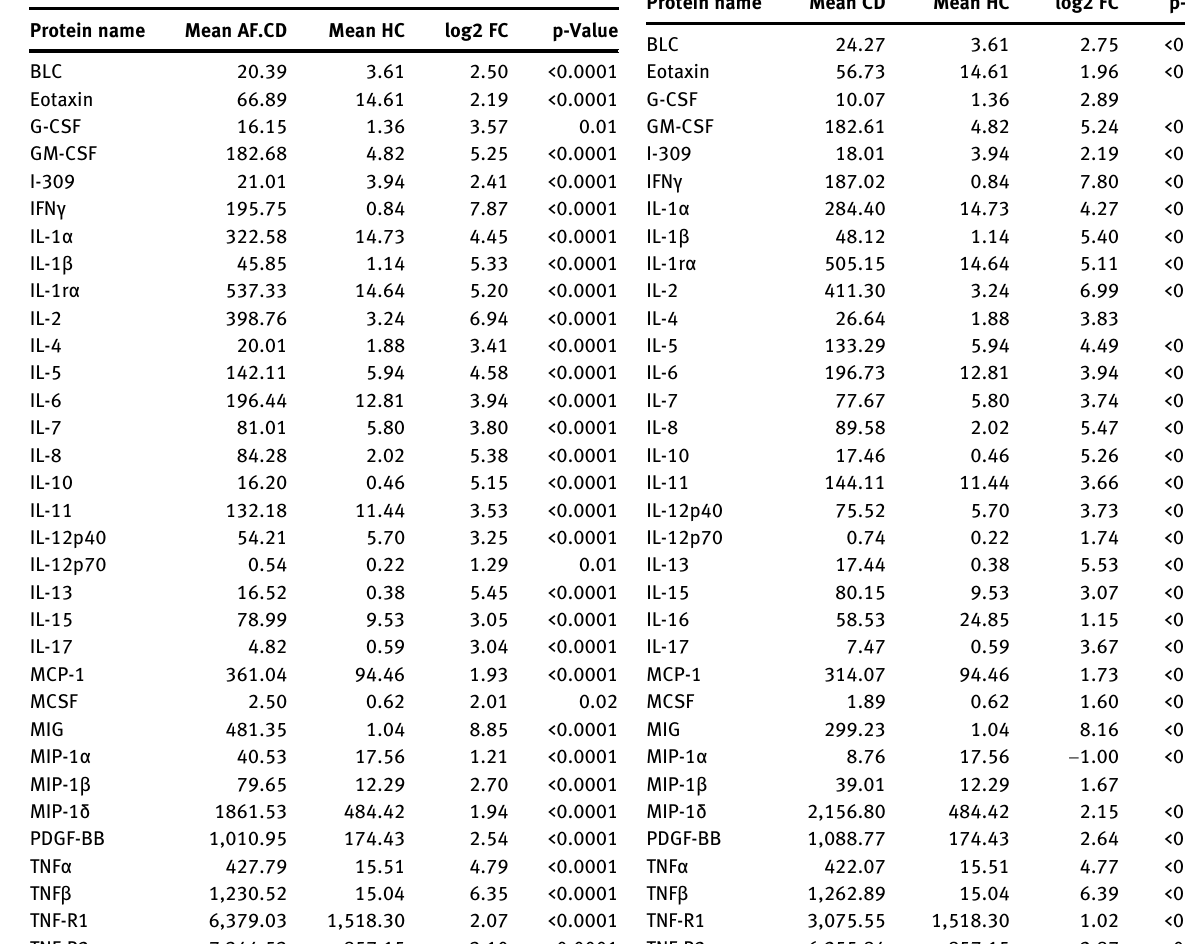
Table  : Differential expressed serum proteins between  CD only and six healthy samples detected by antibody arrays.